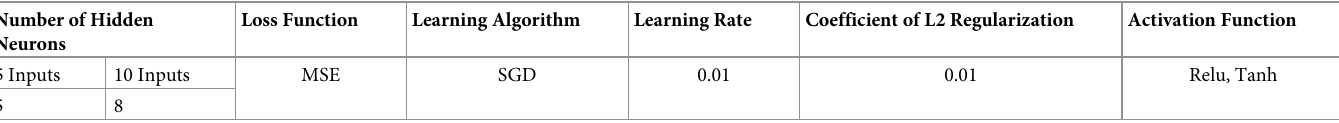
Table 10. Parameters for NNR model by Wrapper Approach.